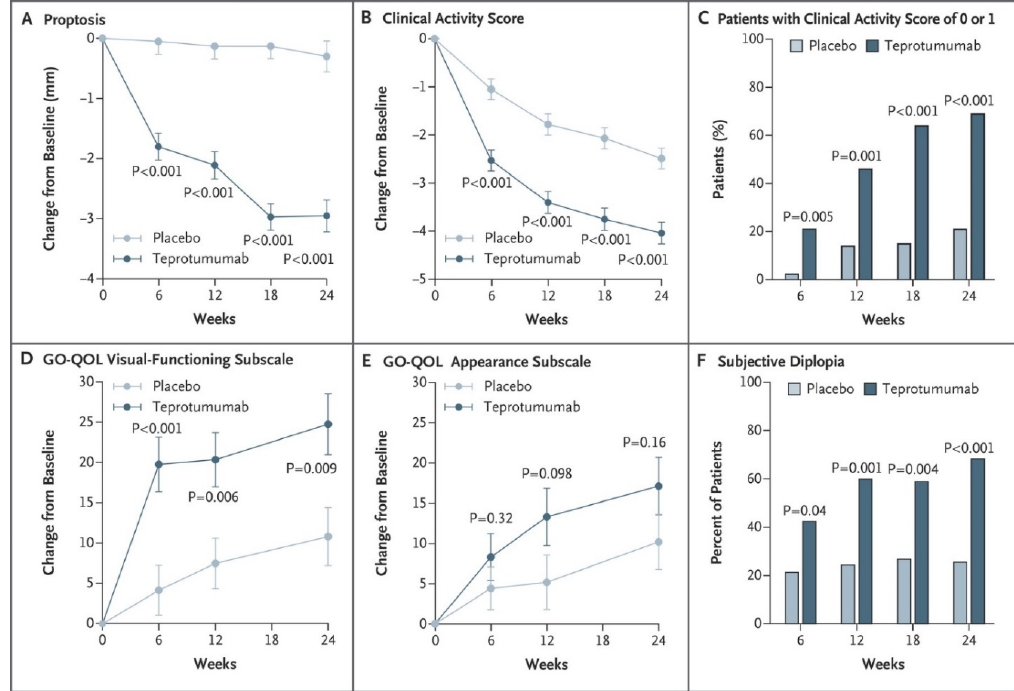
Figure 5. Secondary end points in phase 2 clinical trial of teprotumumab. ( A ) Changes in proptosis over time from baseline. ( B ) Changes in CAS over time from baseline. ( C ) Post hoc analysis showing fraction of patients achieving 0–1 CAS as a function of time. ( C ) Change in QOL visual functioning subscale (GO-QOL). ( D ) GO-QOL visual functioning subscale. ( E ) Change in GO-QOL appearance subscale. ( F ) Diplopia responses. From Smith TJ, Kahaly GJ, Ezra DG, Fleming JC, Dailey